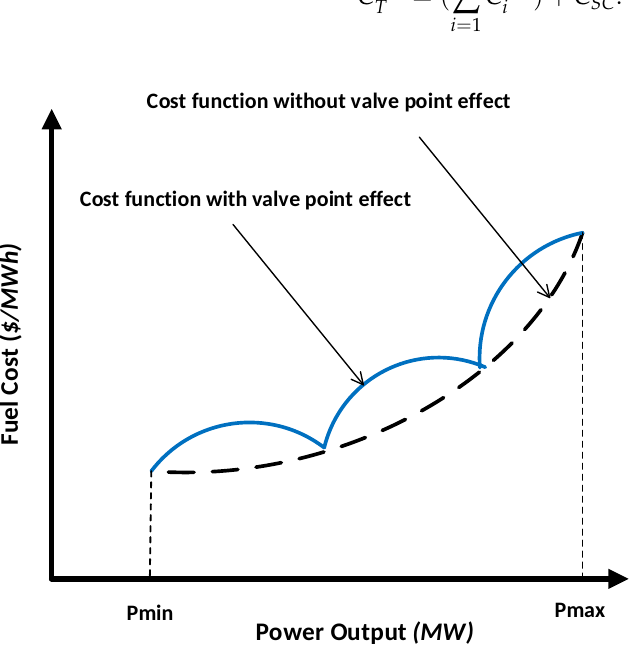
Figure 1. The cost function with and without valve-point